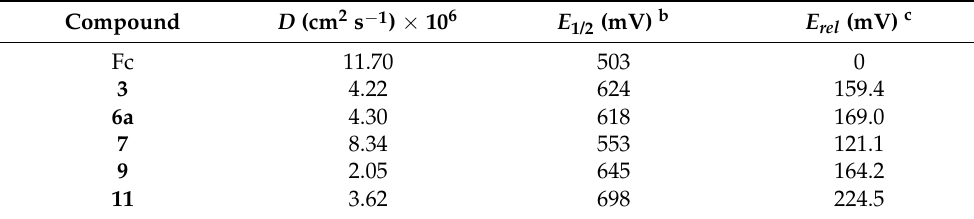
Table 2. Diffusion coefficients ( D ), half wave potentials ( E 1/2 ) and redox potentials relative to ferrocene ( E rel ) of ferrocene–benzofuran hybrids a .